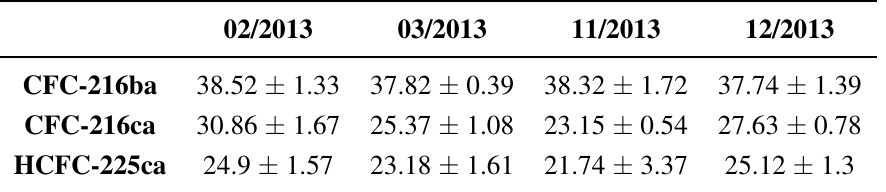
Table 1. Mixing ratios of CFC-216ba, CFC-216 and HCFC-225ca in Civil Aircraft